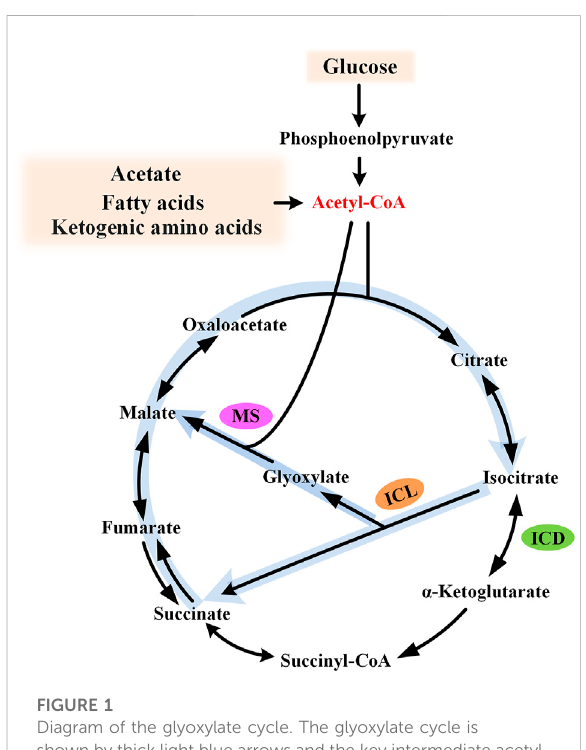
FIGURE 1 Diagram of the glyoxylate cycle. The glyoxylate cycle is shown by thick light blue arrows and the key intermediate acetyl- CoA isshown inred.ICL, isocitrate lyase; MS, malate synthase; and ICD, isocitrate